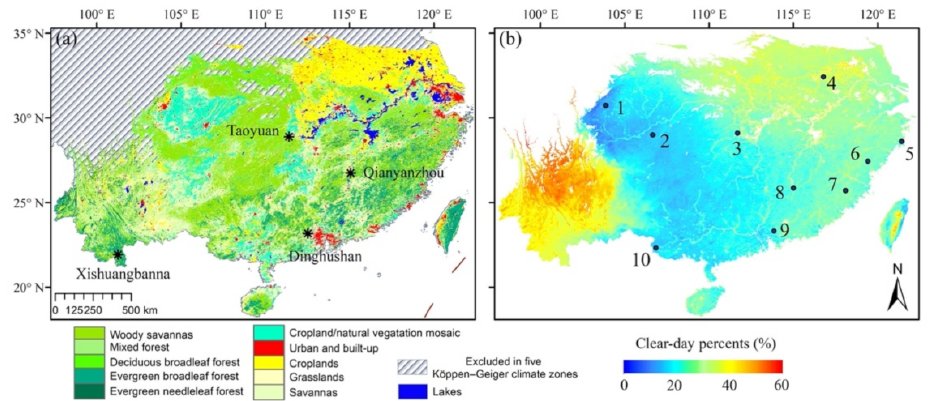
Figure 1. Basic information about the study area of South China. ( a ) The land cover category in 2015 from the Moderate Resolution Imaging Spectroradiometer (MODIS) Land Cover Type MCD12Q1 version 6 data product (https://lpdaac.usgs.gov/products/mcd12q1v006/ (accessed on 12 Novem- ber 2020).) and the spatial distribution of four ChinaFLUX ground flux towers. ( b ) The percentage of valid clear-sky observations in the MODIS MYD11A1 land surface temperature (LST) product and the spatial locations of ten automatic meteorological stations. The slash or blue areas indicate the pixels with full of water surface or not belonging to the five Köppen–Geiger climate types in South